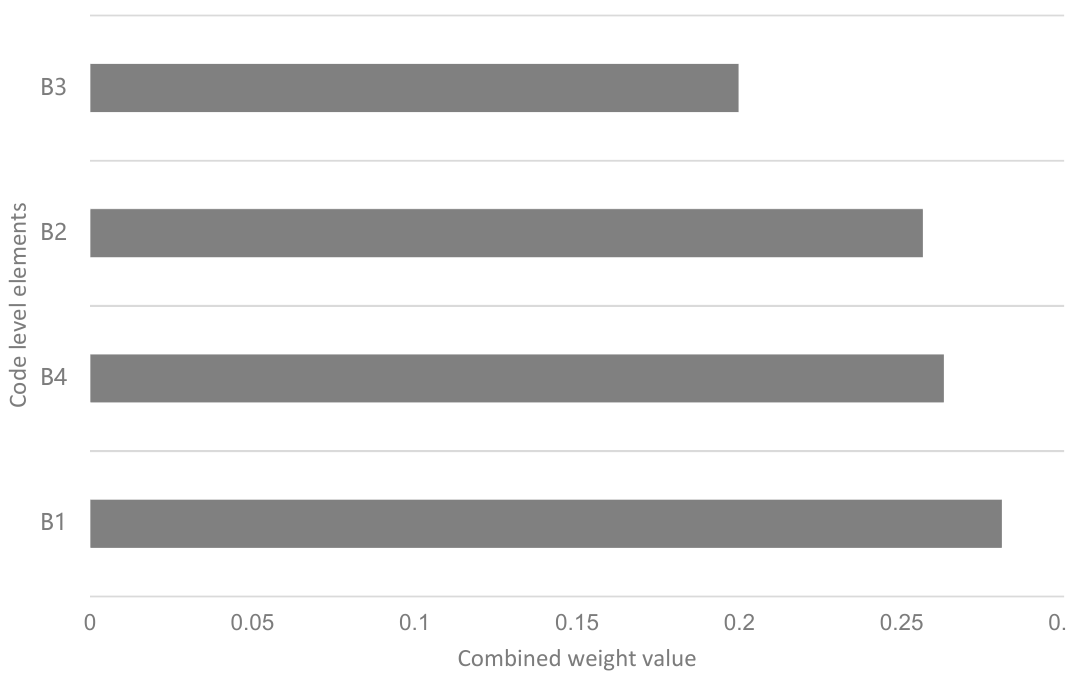
Figure 2. Statistical comprehensive weight values of criterion layer.